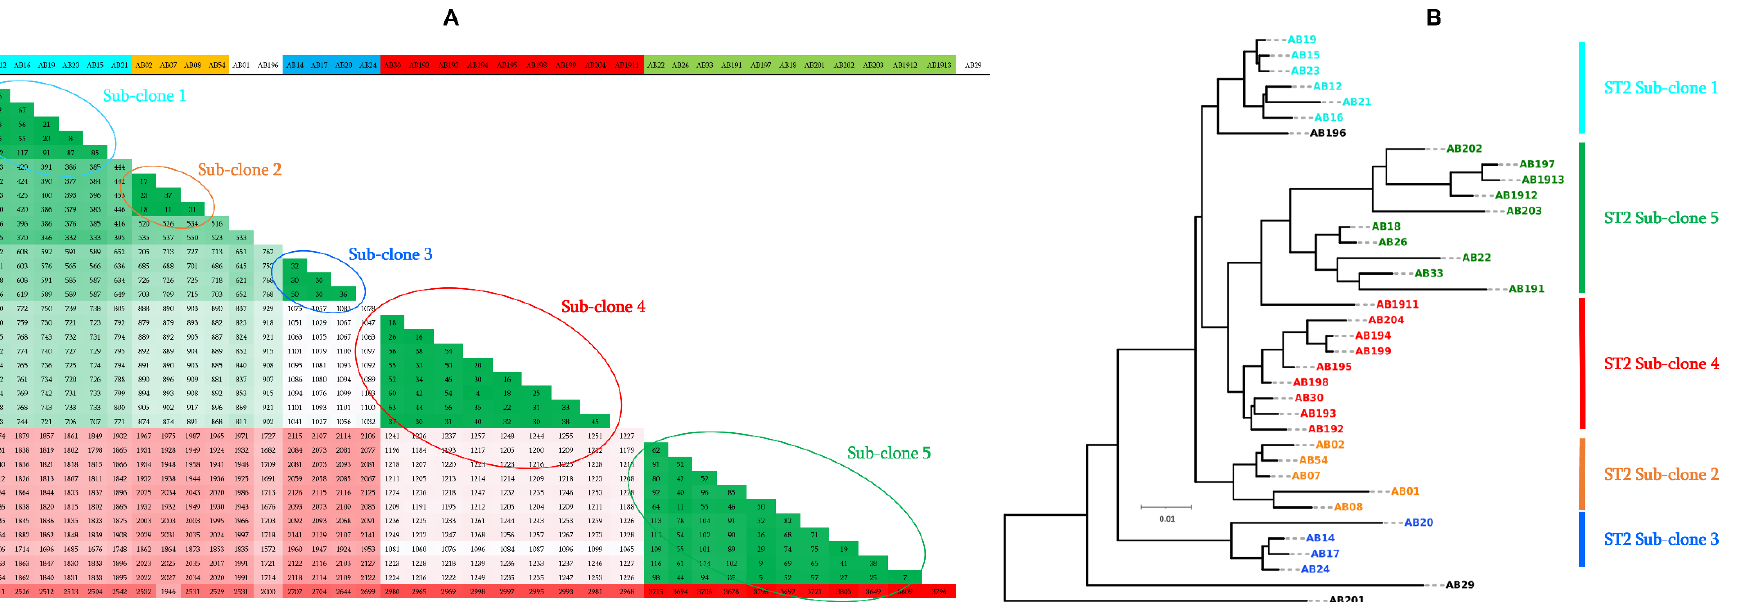
Figure 2. Genomic characterization of clinical A. baumannii isolates. ( A ) Pairwise comparison of genomic gSNPs of A. baumannii isolates demonstrating the existence of five circulating sub-clones in this hospital setting. ( B ) Whole-proteome-based phylogenetic tree of A. baumannii isolates highlighting the observed sub- clones.